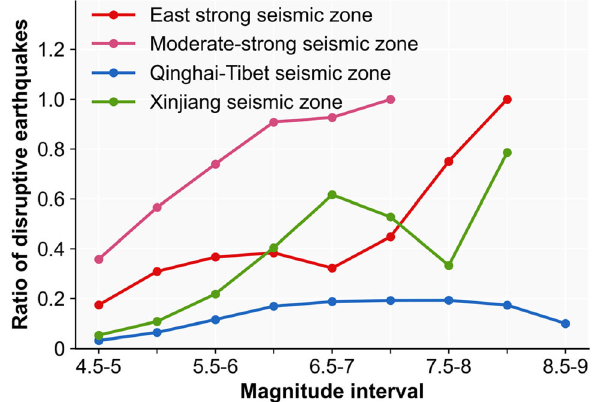
Fig. 6 Ratio of disruptive earthquakes in different peak ground acceleration